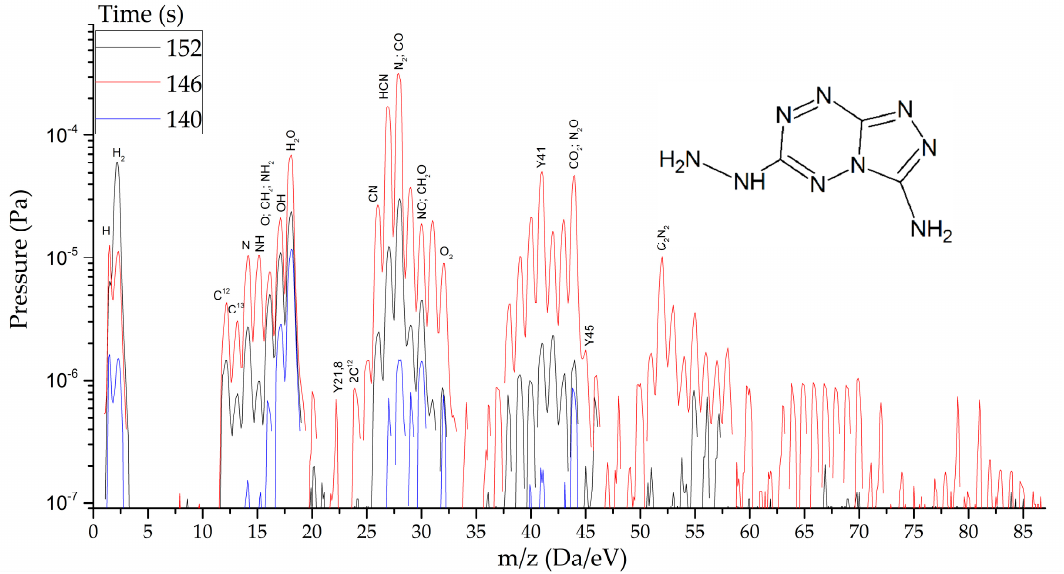
Figure 9. Mass spectra of gaseous products of TTGA reactions at the peak of decomposition at heating rates from 1.5 to 2000 s − 1 .